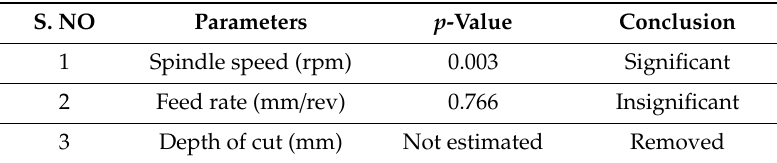
Table 4. P-values for three process parameters. Table 4. p -values for three process